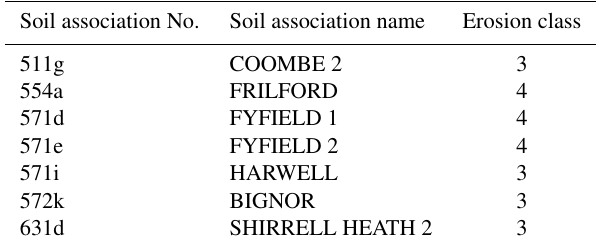
Table 1. Soils at moderate (3) and high (4) risk of soil erosion within the Rother catchment (Evans,